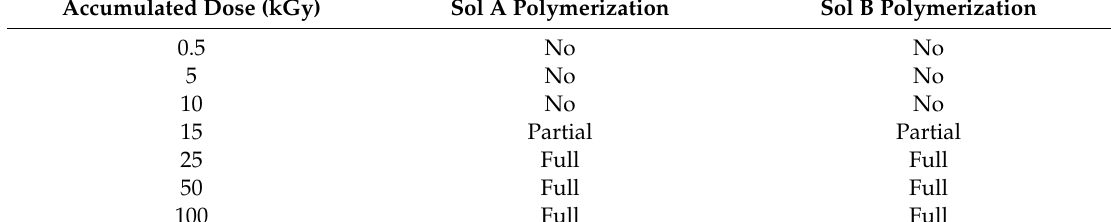
Table 1. Effect of X-ray accumulated dose (kGy) on the photopolymerization of sol A (photo-initiator) and B (photo-initiator free).